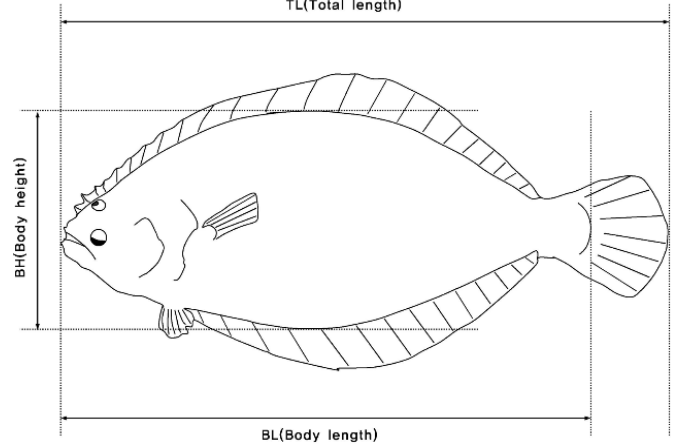
Figure 2. Method of measuring the body parts of farmed olive flounder ( Paralichthys olivaceus ). For the sample for paternity confirmation, 100 µ g of pectoral fin tissue was placed in a microwell plate pre-dispensed with 5% Chelex 100 solution, and proteinase K treatment was performed at 55 ◦ C for 30 min. After heat treatment at 100 ◦ C for 10 min, centrifugation was performed, and the supernatant was used for multiplex PCR reaction. Eight loci